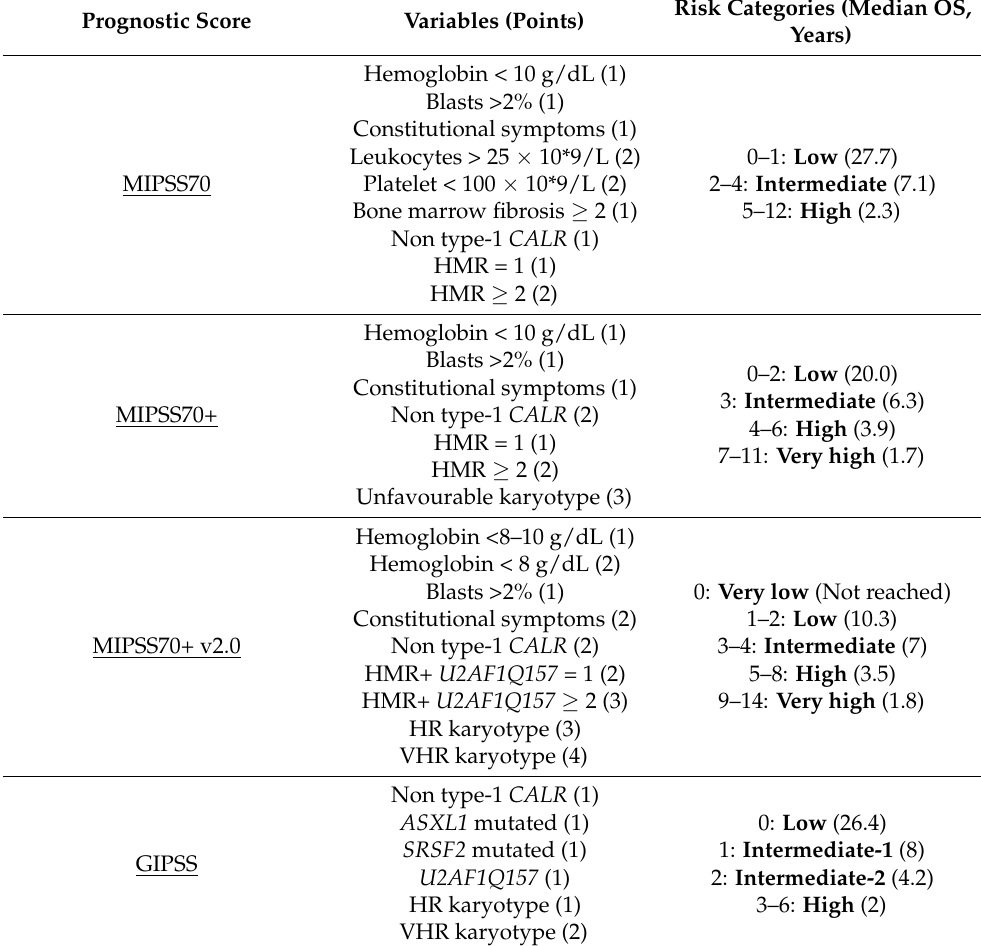
Table 2. Prognostic scores in PMF and secondary MF with clinical and molecular